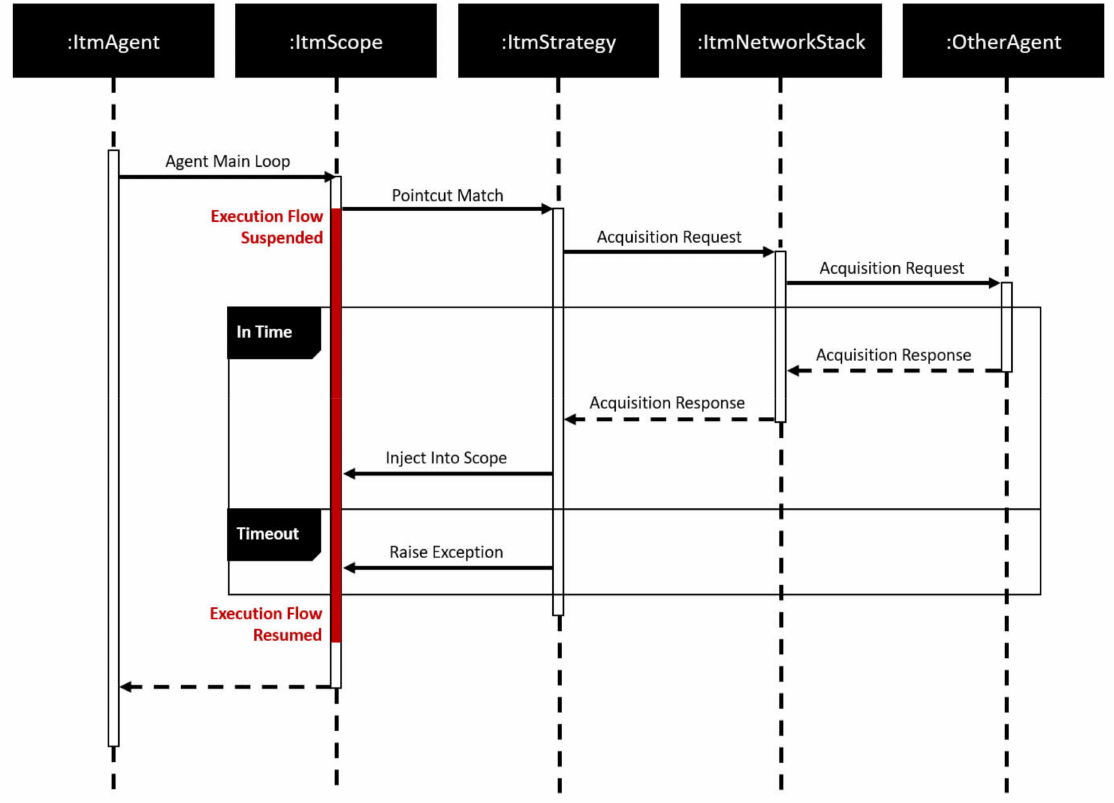
Figure 8. Aspect-weaving behavior of the ItmPy framework matching a pointcut on a missing